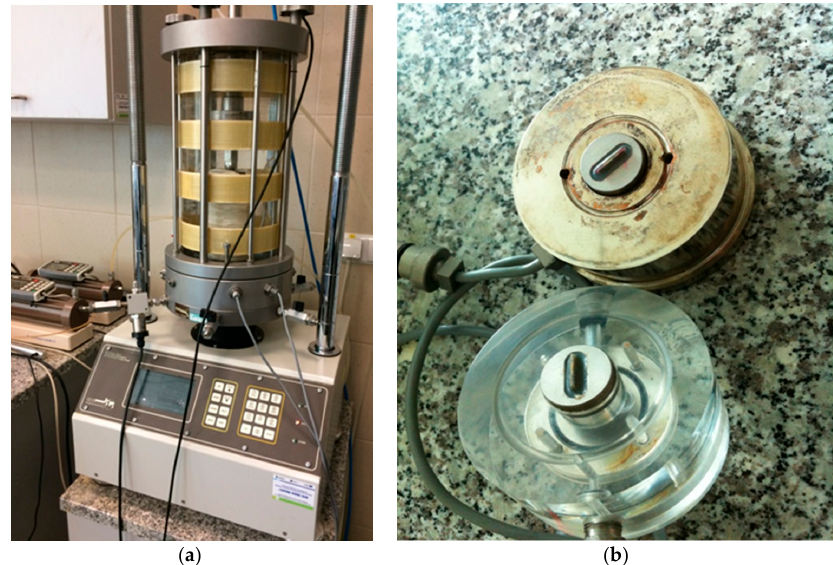
Figure 8. Triaxial apparatus device with Bender Elements. ( a ) Triaxial apparatus; ( b ) bender elements, bottom: transmitter, top: receiver. Table 3. Shear wave velocity ( V S ) of pure RCA specimens by four different methods of interpretation and three different mean effective stresses.